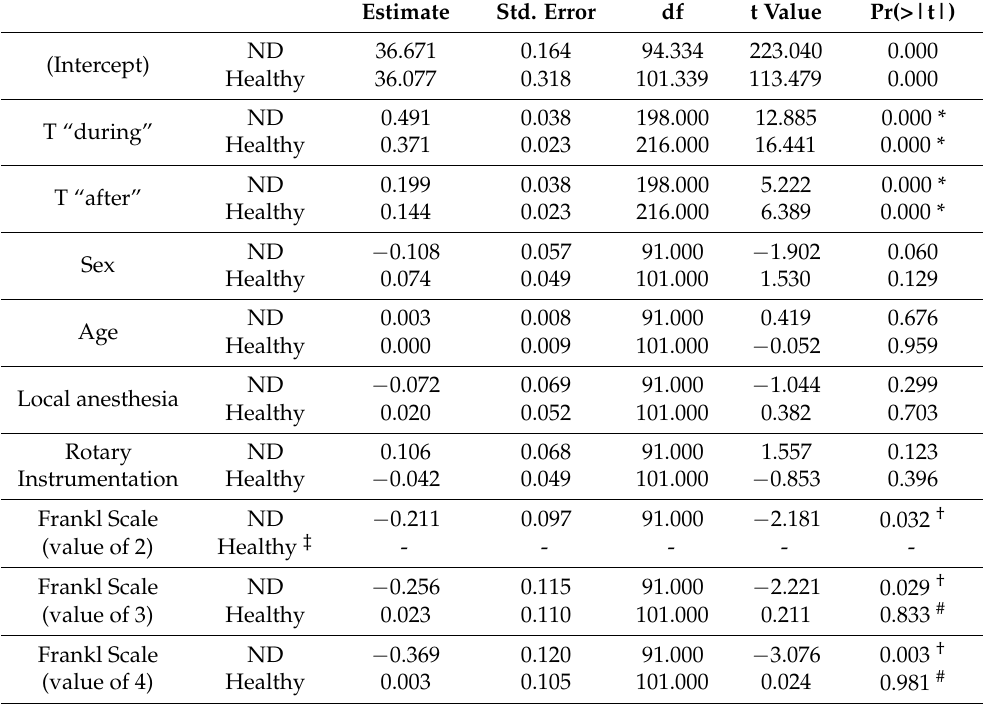
Figure 1. Forehead temperature values in the children with neurodevelopmental disorders in relation to the patient’s behavior, evaluated with the Frankl scale (Frankl, 1962). Frankl 1 = “definitely negative”; Frankl 2 = “negative”; Frankl 3 = “positive”; and Frankl 4 = “definitely positive”. Table 3. Variables that determine the forehead temperature values applying a mixed linear model in children with neurodevelopmental disorders (ND) and in healthy children (healthy) .